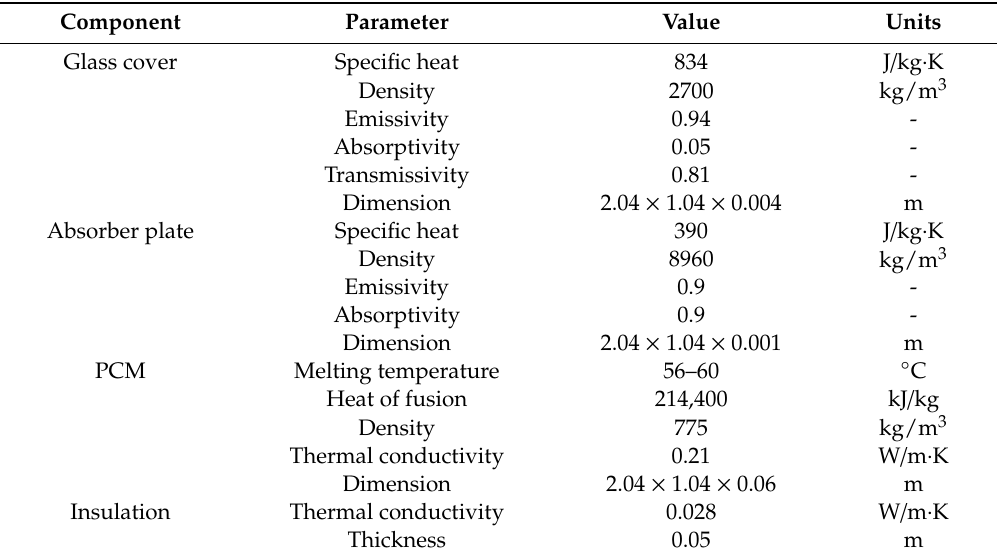
Table 2. Input parameters.